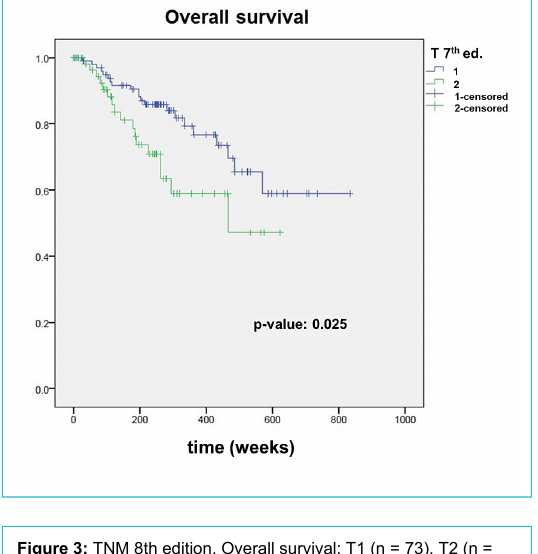
Figure 4: TNM 7th edition. Disease-specific survival: T1 (n = 102) and T2 (n = 59); here the difference between the two curves is not significant but shows a trend towards worse survival for T2 pa- tients.